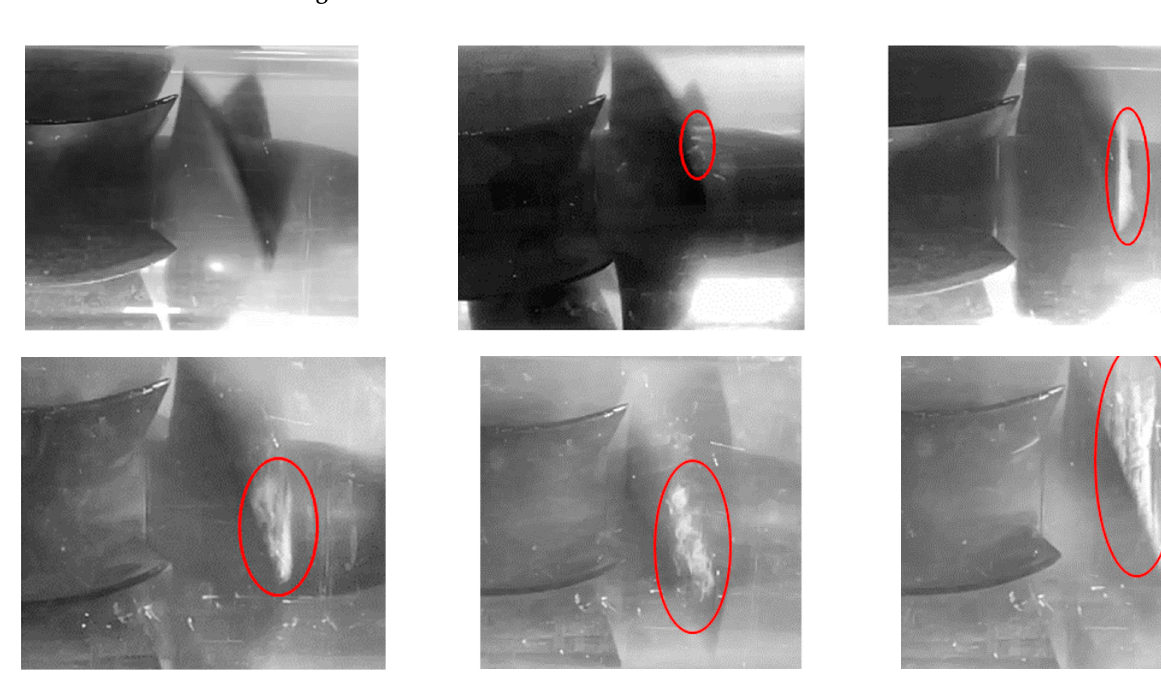
Figure 17. Acceleration scheme 2.